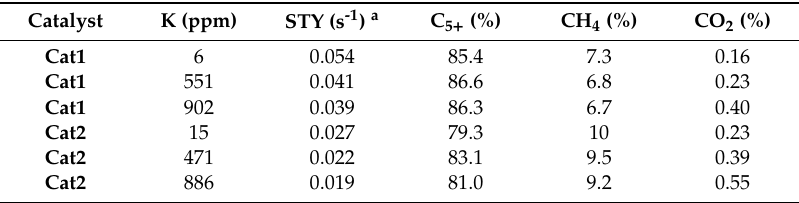
Table 2. Catalytic activity reported as site time yield (STY) and selectivities to C 5 + , CH 4 and CO 2